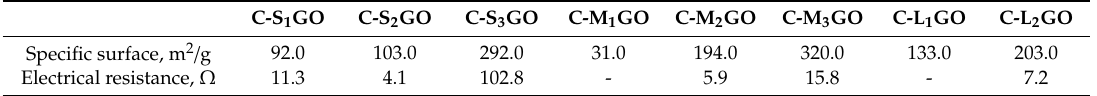
Table 9. Collection of specific surface values and electrical resistance for cross-linked graphene oxide powders.